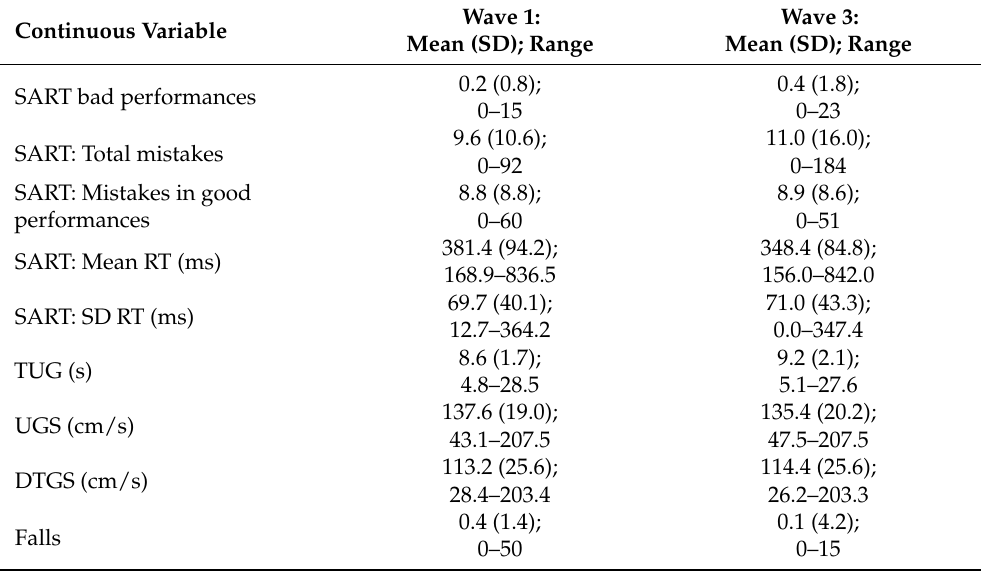
Table 1. Descriptive statistics for the whole set of variables considered in this study for the merged dataset ( N = 3468) at wave 1 and wave 3. The first part of the table gives minimum, maximum values, and mean and SD for each continuous variable. The second part shows ordinal or nominal variables and their frequency in